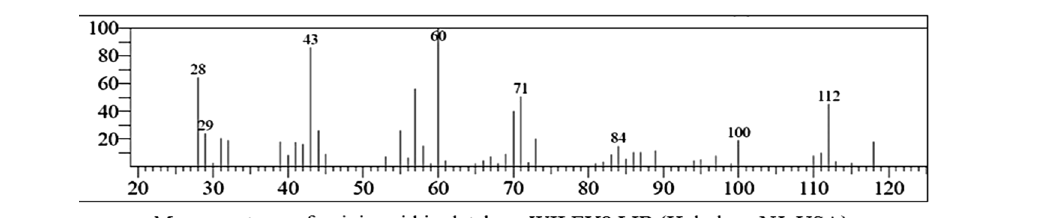
Fig. 6 Mass-spectrum of quinic acid (most abundant component with 45.9% peak area) in sample